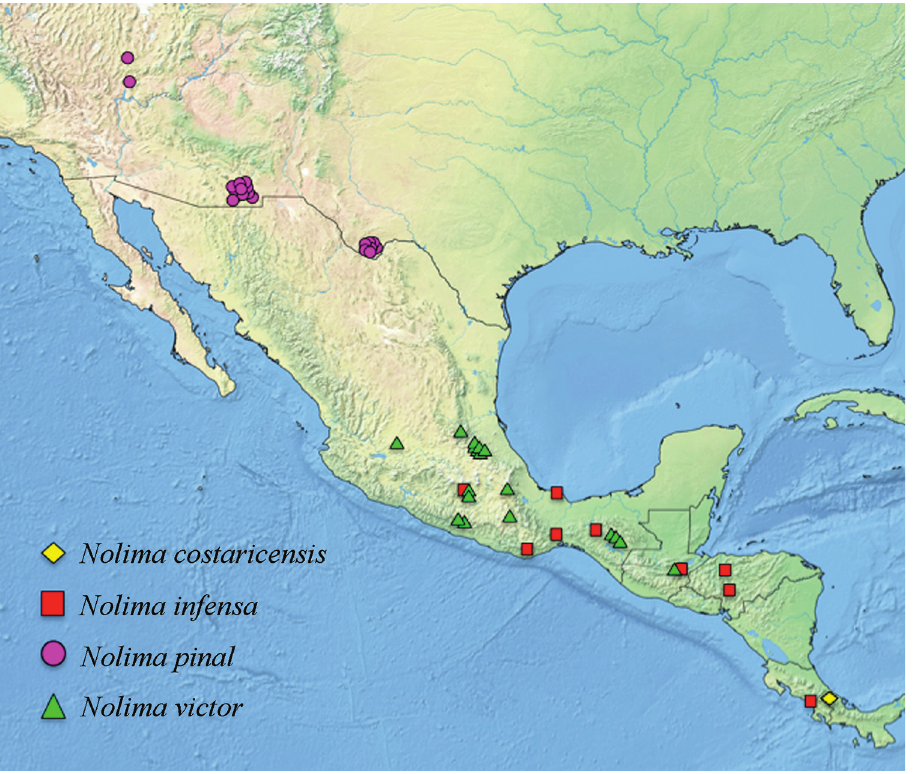
Figure 7. Distribution of the species in the genus Nolima